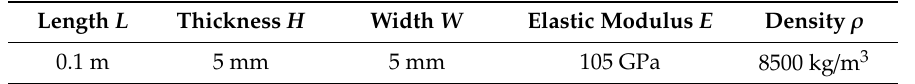
Table 1. Parameters of the touch beam.